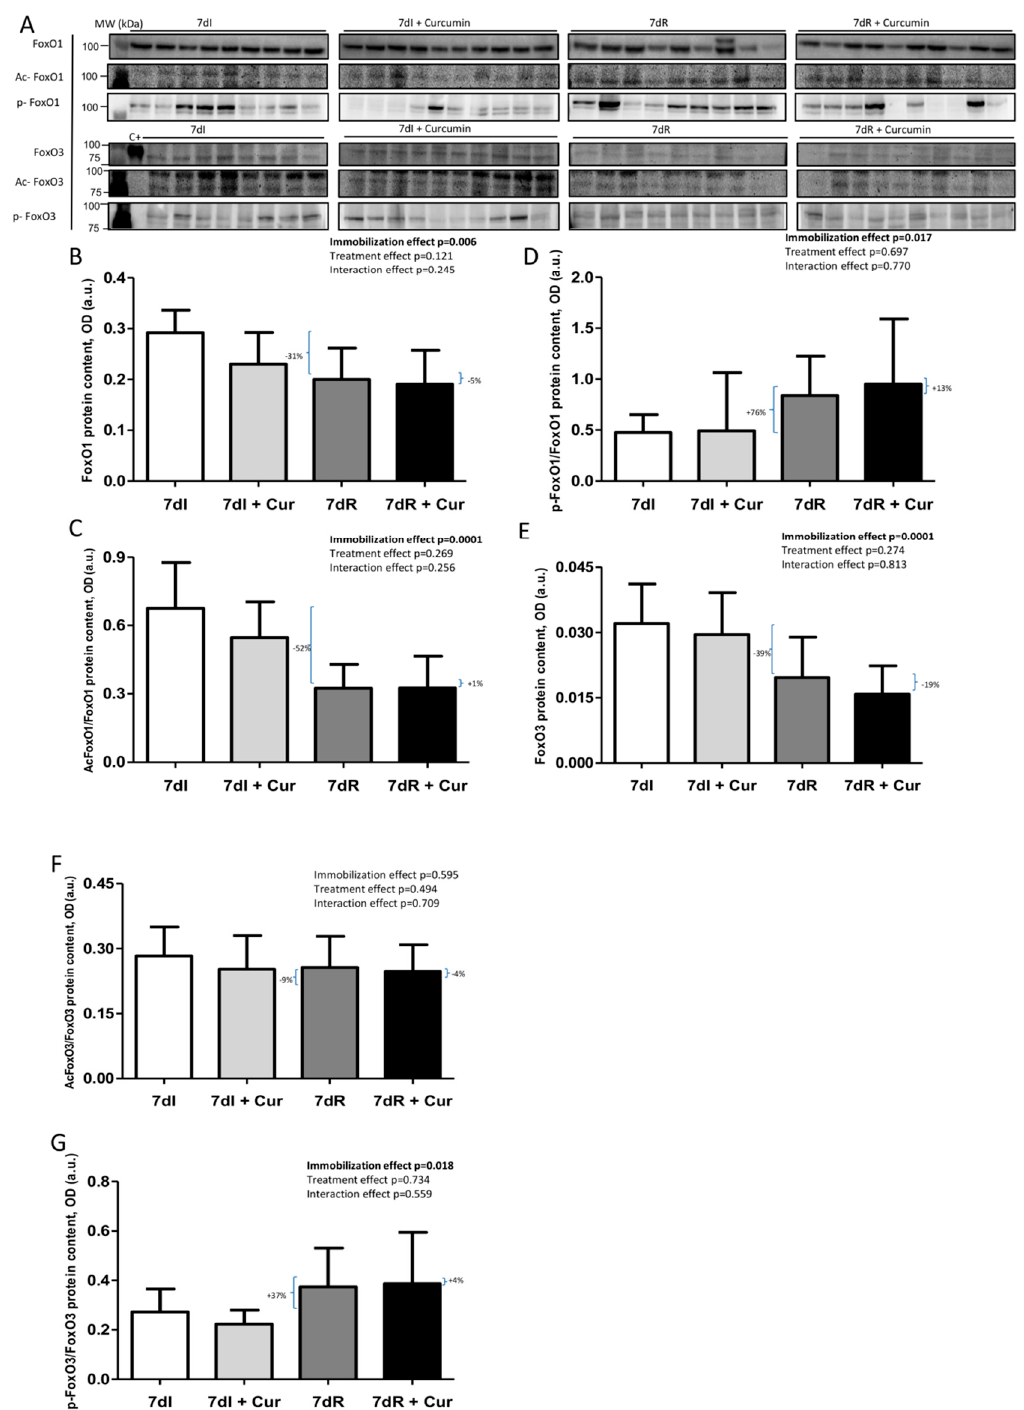
Figure 8. ( A ) Representative immunoblots of FoxO1, acetylated FoxO1, phosphorylated FoxO1, FoxO3, acetylated FoxO3 and phosphorylated FoxO3 proteins in the gastrocnemius muscle of all study groups of mice. Definition of abbreviations: FoxO1, transcription factor fork-head box O1; FoxO3, transcription factor fork-head box O3; ac-, acetylated; p-, phosphorylated; C + , positive control; MW, molecular weight; kDa, kilodalton; I, immobilization; R, recovery. ( B ) Mean values and standard deviation of FoxO1 protein content in the gastrocnemius muscle of the different study groups of mice, as measured by optical densities in arbitrary units (OD, a.u.). Definition of abbreviations: FoxO1, transcription factor fork-head box O1; OD, optical densities; a.u., arbitrary units; I, immobilization; R, recovery; Cur, curcumin. The statistical analyses (two-way ANOVA test) of the effect of